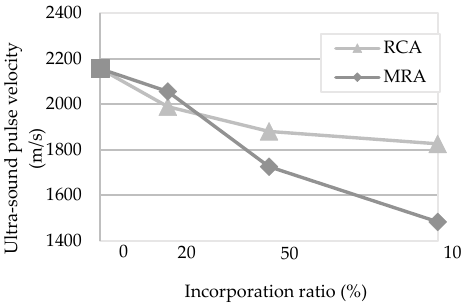
Figure 4. Ultrasound pulse velocity of the mortars tested by direct method at 90 days.